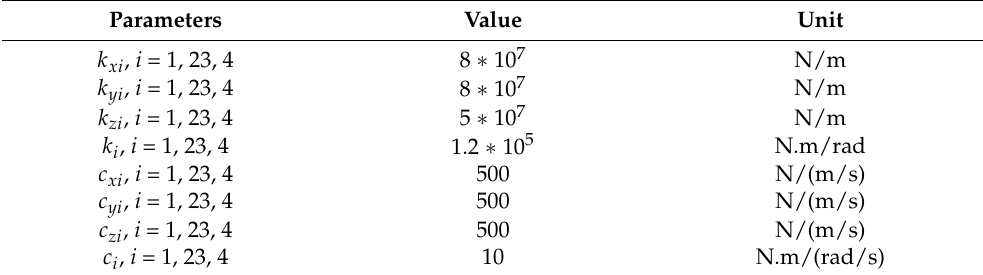
Figure 8. The two ‐ stage drive system. ( a ) The physical model. ( b ) The dynamic model. Figure 8. The two-stage drive system. ( a ) The physical model. ( b ) The dynamic model. Table 2. Stiffness and damping parameters used in the transmission